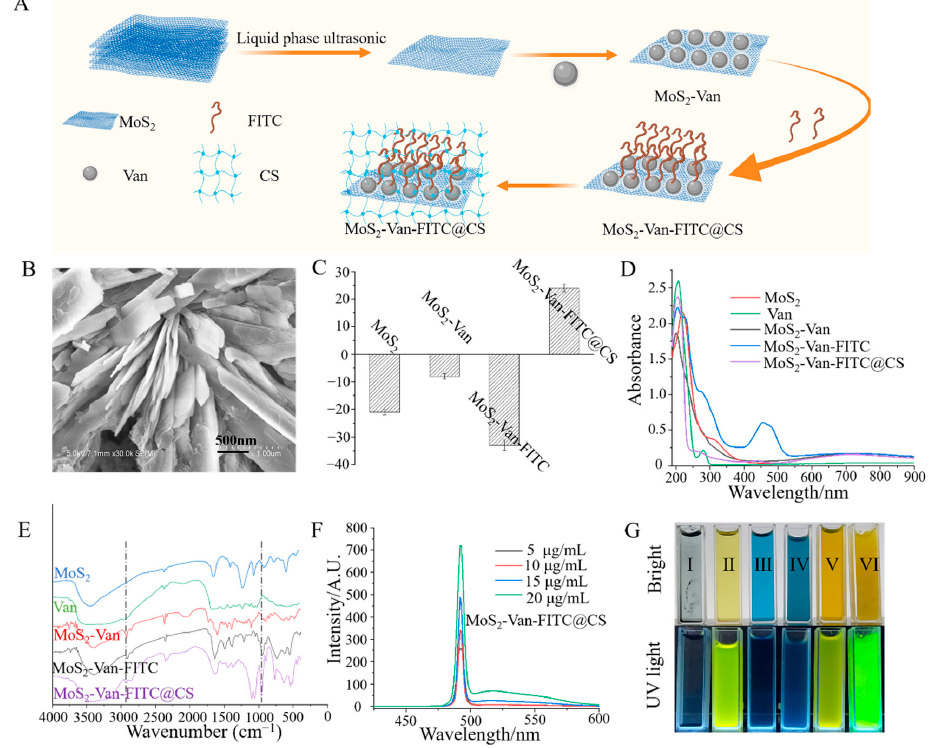
Figure 2. Synthesis and characterization of MoS 2 -Van-FITC@CS. ( A ) Synthesis illustration of MoS 2 - Van-FITC@CS. ( B ) SEM images of MoS 2 NPs. ( C ) Zeta potential of MoS 2 , MoS 2 -Van, MoS 2 -Van-FITC, and MoS 2 -Van-FITC@CS. ( D ) UV-vis absorption spectra of MoS 2 , Van, MoS 2 -Van, MoS 2 -Van-FITC, and MoS 2 -Van-FITC@CS. ( E ) FT-IR spectrometry of MoS 2 , Van, MoS 2 -Van, MoS 2 -Van-FITC, and MoS 2 -Van-FITC@CS. ( F ) Digital images of I (Milli-water), II (FITC), III (MoS 2 ), IV (MoS 2 -Van), V (MoS 2 -Van-FITC), and VI (MoS 2 -Van-FITC@CS) under bright and UV light. ( G ) Fluorescence emission spectra of MoS 2